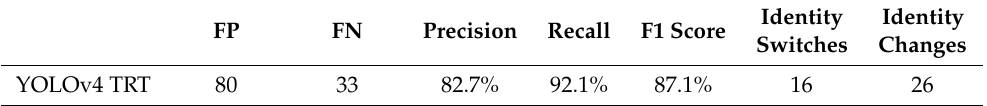
Table 5. Number of false positive detections (FPs), false negative detections (FNs), precision, recall, F1 score, identity switches, and identity changes for the TRT implementation of the YOLOv4 object detection model on test video 1 (resolution of 3840 × 2160, length of 50 s, FPS of 30) captured by a drone, showing 6 classes (car, person, bicycle, bus, monocycle, and truck). FP FN Precision Recall F1 Score